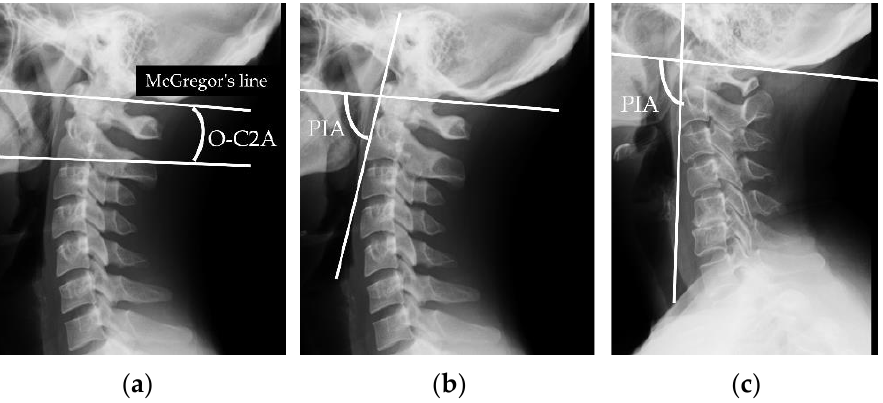
Figure 1. ( a ) Occipito-C2 angle (O-C2A: angle between McGregor’s line and lower endplate of C2). ( b ) Pharyngeal inlet angle (PIA) is defined as the angle between McGregor’s line and the line that links the center of the C1 anterior arch and the apex of the cervical sagittal curvature. The swallow line (S-line) (−) is PIA < 90°. ( c ) The swallow line (S-line) (+) is PIA > 90°.